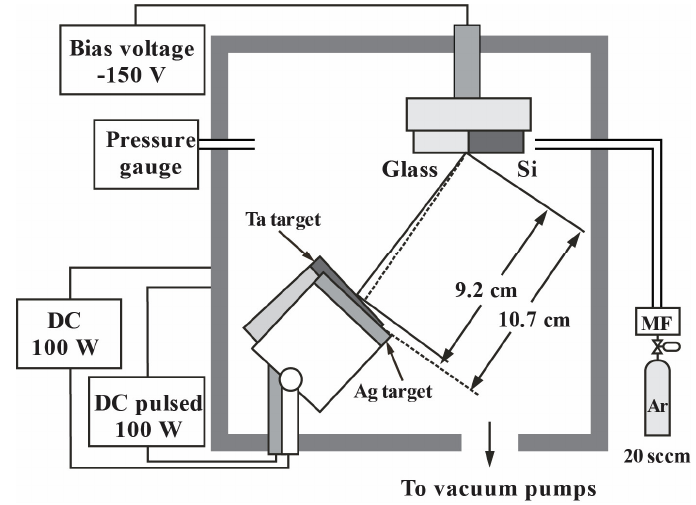
Figure 1. Schematic diagram of DC magnetron co-sputtering system.